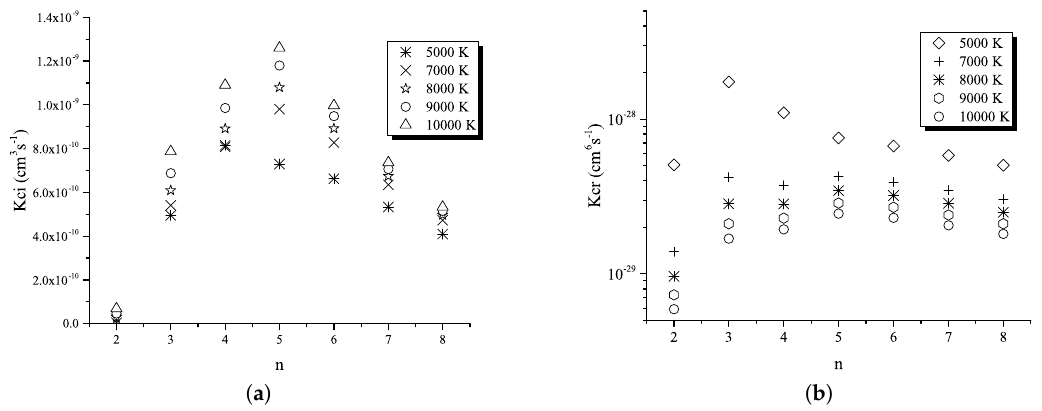
Figure 3. ( a ) total chemi-ionization rate coefficients Kci ( n ; T ; H ) with 5000K ≤ T ≤ 10,000 K and for principal quantum numbers n = 2–10; ( b ) same as in ( a ) but for the inverse recombination coefficients Kr ( n ; T ; H ) (data taken from [35]).